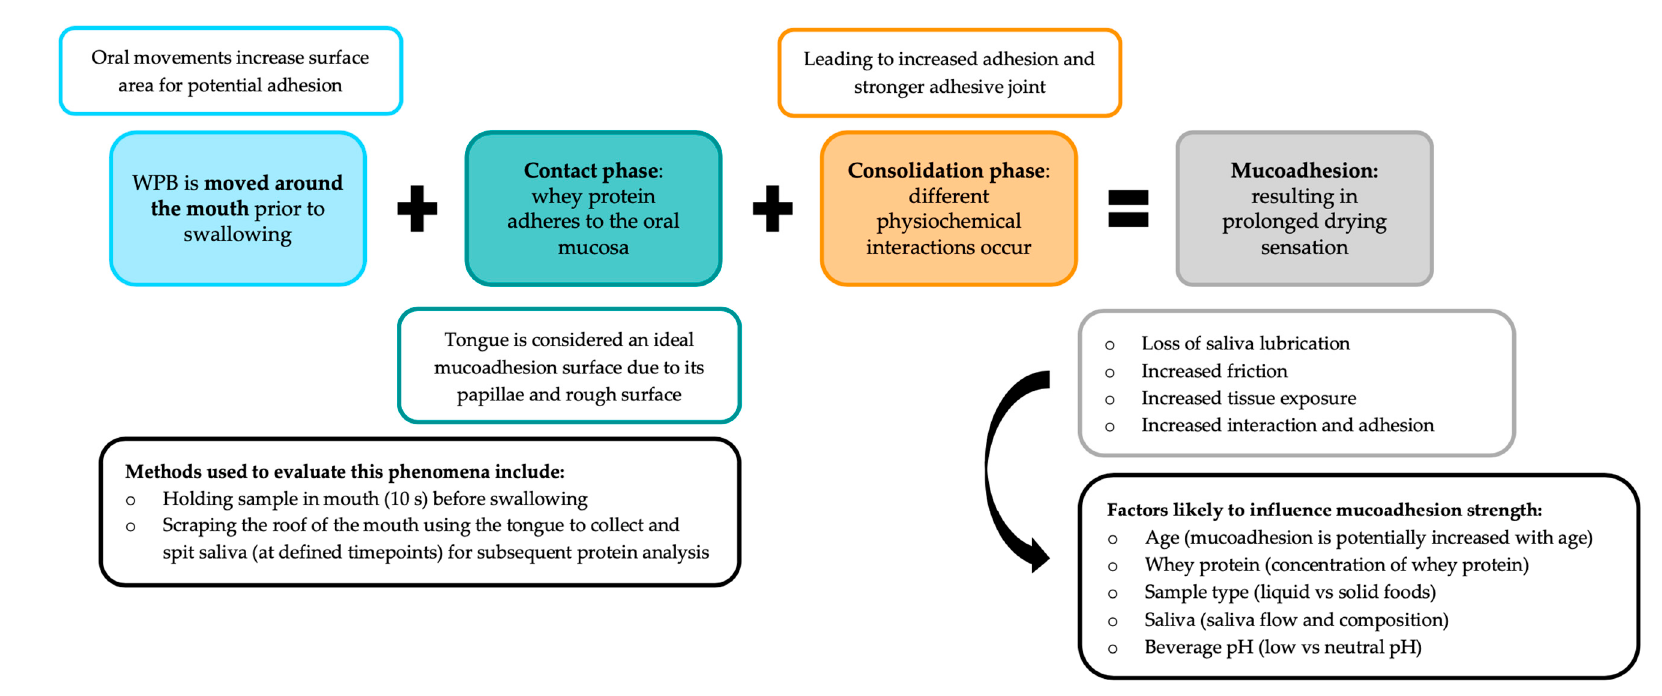
Figure 3. Proposed mucoadhesion mechanism of neutral pH whey protein beverages (WPB) [89,128,134,136,138,144,147].